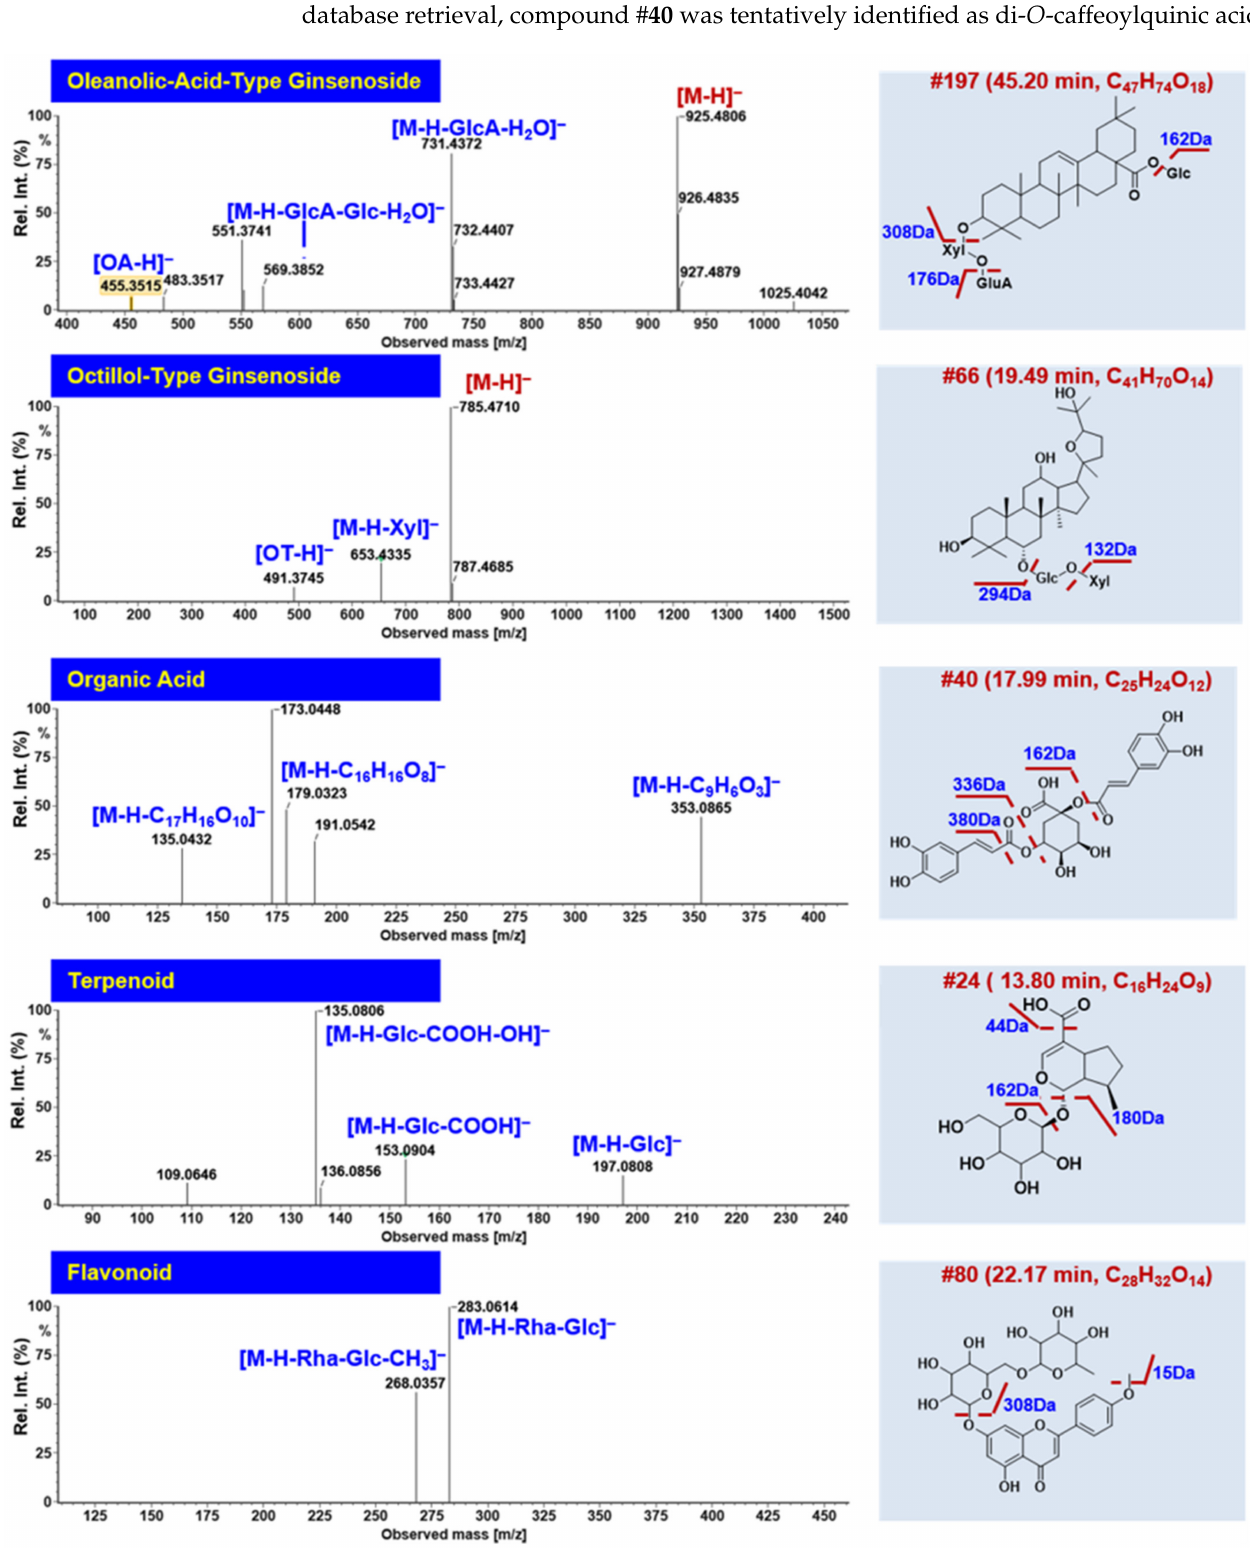
Figure 7. Annotation of the CID-MS 2 spectra of the oleanolic-acid (OA) and octillol (OT)-type ginsenosides, organic acids, terpenoids, and flavonoids from WXG using UNIFI TM